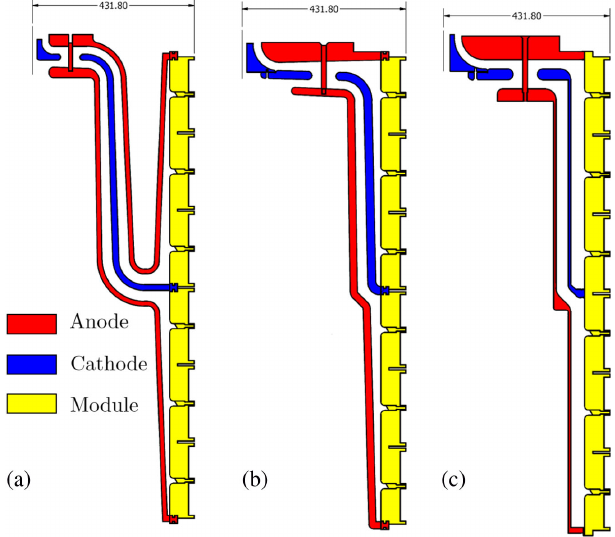
FIG. 3. The three different transmission lines studied in this paper: (a) wrapped, (b) conical, and (c) straight transmission lines.